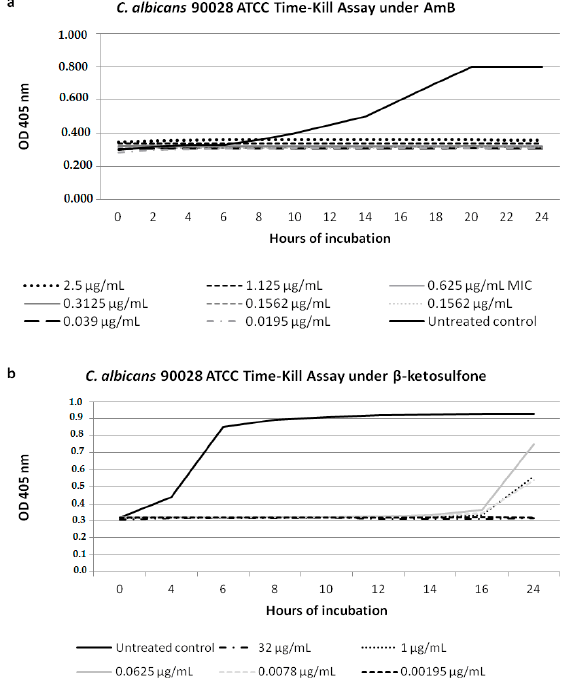
Figure 2. Characterization of growth of the Candida strains in the presence of Compound 4 . The suspensions were prepared with organisms in log phase growth and diluted in Sabouraud Dextrose Broth SDB medium to obtain a final inoculum of 2.5 × 10 2 − 10 3 cfu/mL (OD 405 nm). The effect of the antifungal agent of AmB was used as a control growth inhibition assay during 24 h against the reference strain of 90028 ( a ); ( b ) Compound 4 showed a very good inhibitory effect against 90028. The antifungal nature of Compound 4 against 90028 was determined in the growth inhibition curve studies. Compound 4 was tested at the highest concentration of 32 µ g/mL and at the lowest one of 0.00195 µ